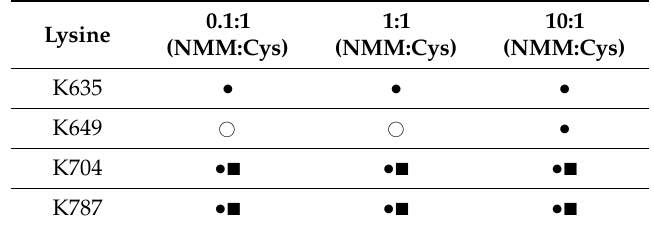
Table 3. The observed N -methylmaleimide (NMM) adducts to lysines in human TRPA1 and ∆ 1-688 human TRPA1 from both trypsin and chymotrypsin digested peptides. The proteins were incubated at di ff erent concentrations of NMM, corresponding to di ff erent molar ratios relative the total number of